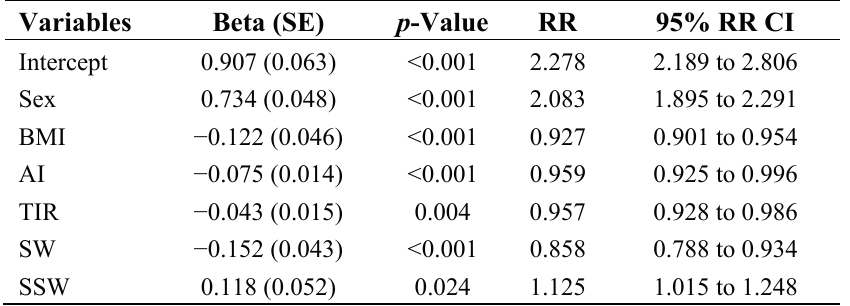
Table 3. MVPA Poisson regression coefficients, standard errors (SE), p -values, rate ratios (RR) and corresponding 95% confidence intervals (95%